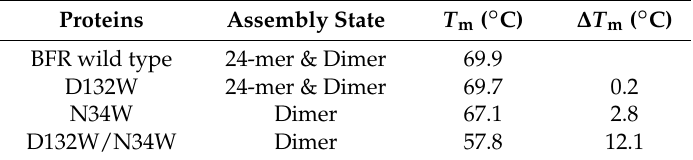
Figure 5. The role mutation plays in the thermal stability and folding reversibility of three mutants at the B-site interface. ( A ) CD spectra of the BFR derivatives before denaturation (solid line) and after slow cooling post-thermal denaturation (dashed lines); ( B ) Thermal transitions of the three mutants at B-site interface as monitored by CD at 222 nm. Data were collected at 1 °C intervals over a temperature range of 25 to 95 °C. The solid lines are the fit and the data points are the experimental data. Data is the average of at least three replicates. Table 2. Solution assembly state, melting temperature of BFR-derived mutants at B-site